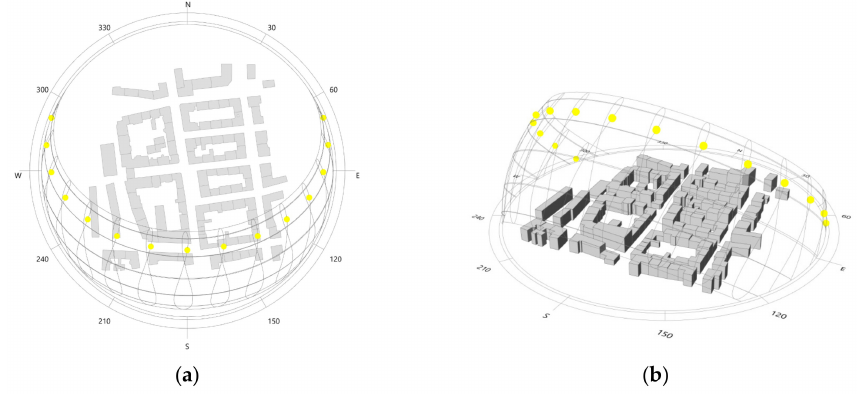
Figure 3. Sun path diagram generated over the study area: ( a ) top view; ( b )